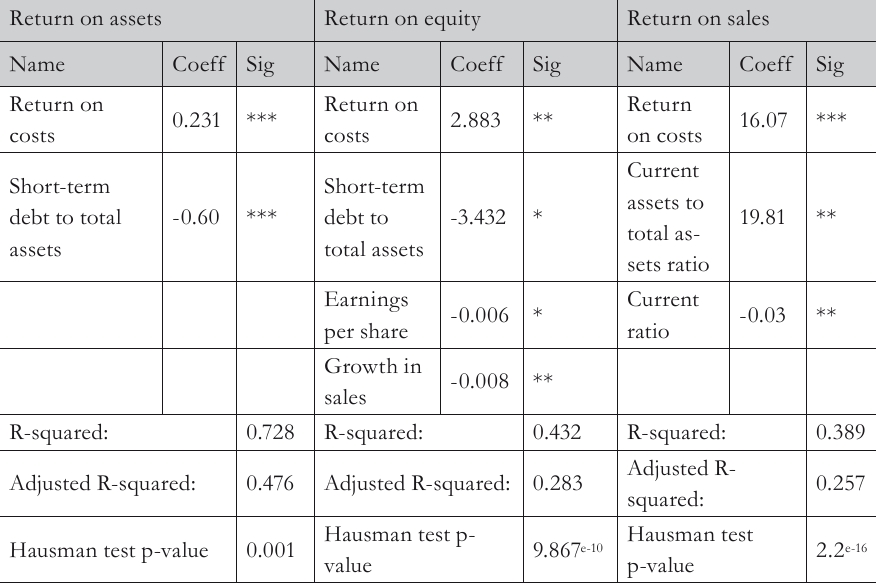
Tab. 8 - Service sector: significant variables predicting ROA, ROE and ROS. Source: